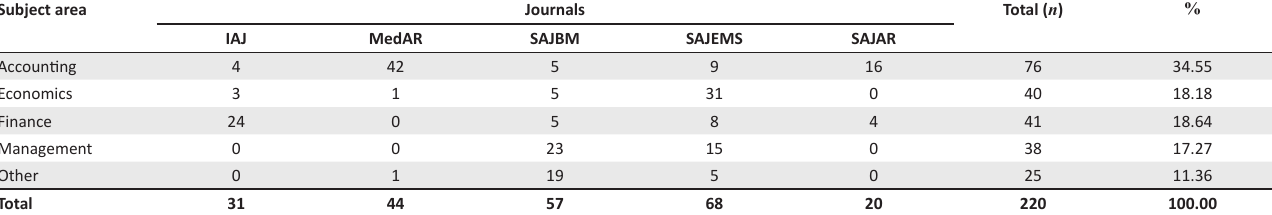
TABLE 3: Management field of articles published during the period